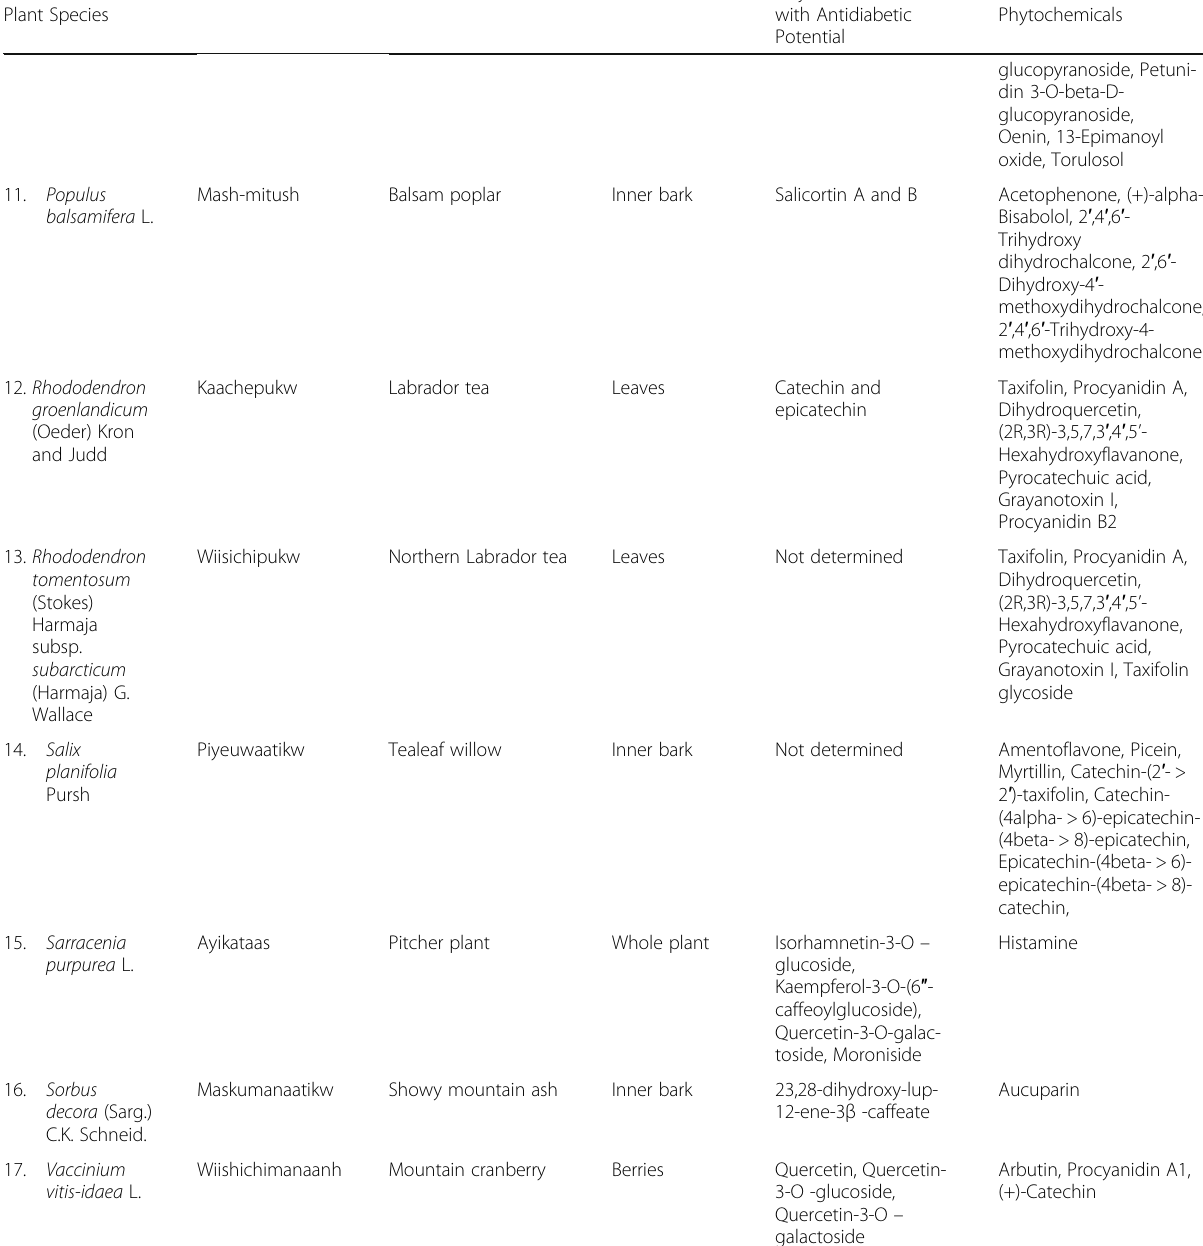
Table 1 Phytochemical characteristics of 17 Cree plant species (Continued) Latin Name of Plant